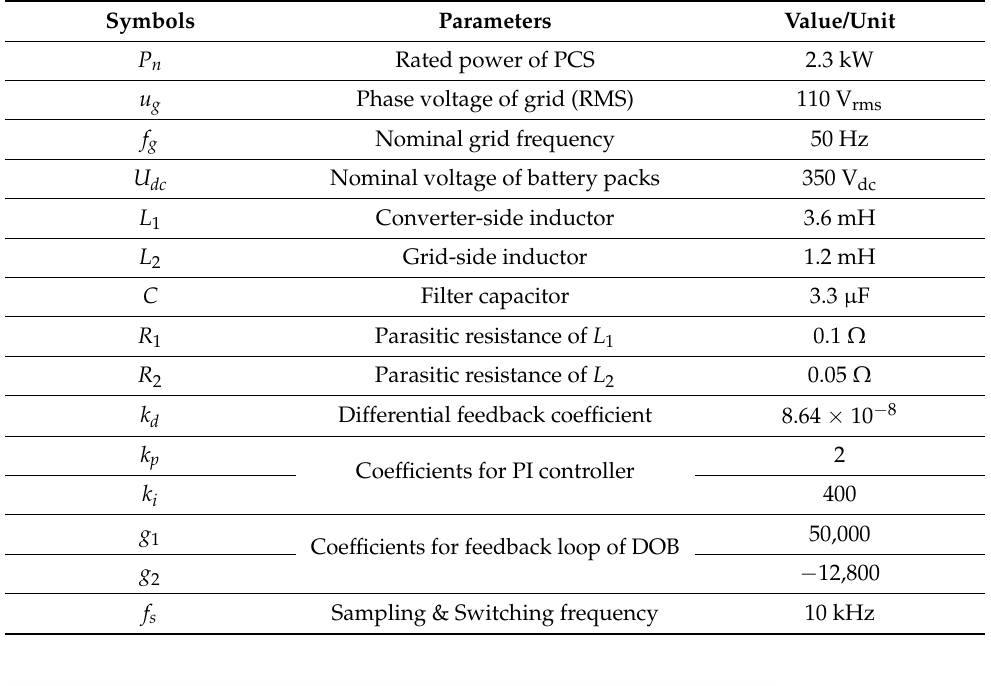
Table 1. Main circuit and control parameters for the PCS.